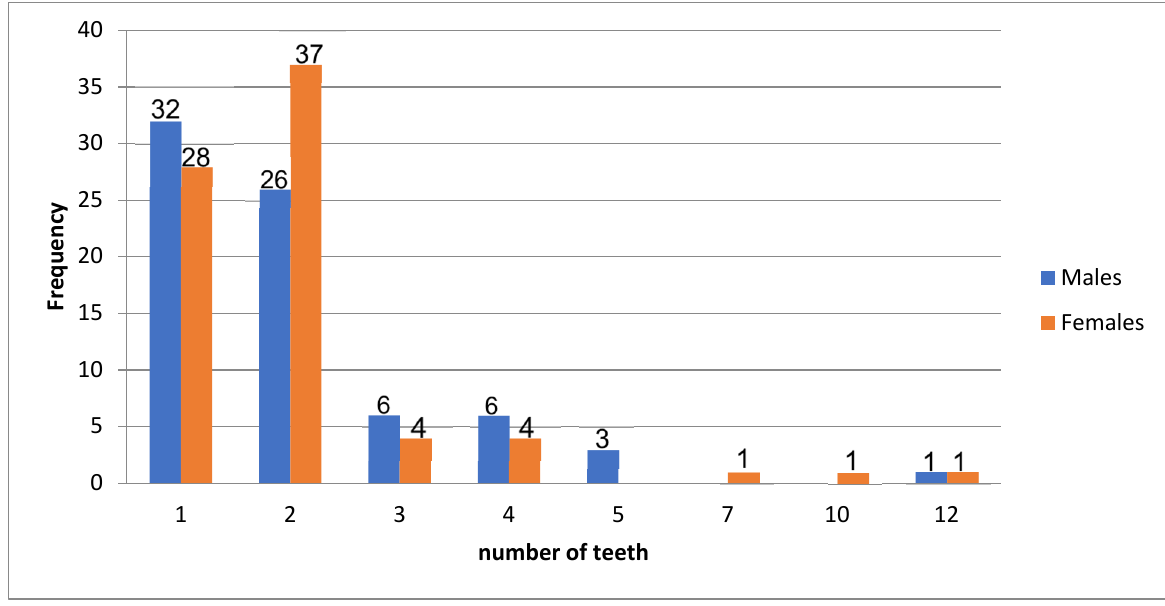
Figure 4. The number of teeth involved in each case among males (blue) and females (red).